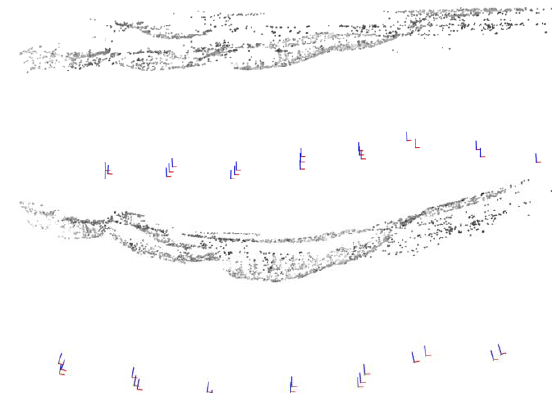
Figure 7. Partial reconstruction results for 20 images of a granite relief captured with an industrial camera. The used lens causes radial distortion of ~250 pixels in the image corners at a sensor size of 1600x1200 pixels. Top: Result with intermediate camera calibration. Bottom: Result with camera calibration activated only during the final adjustment. The adjustment converged before lens distortion effects could be fully compensated.